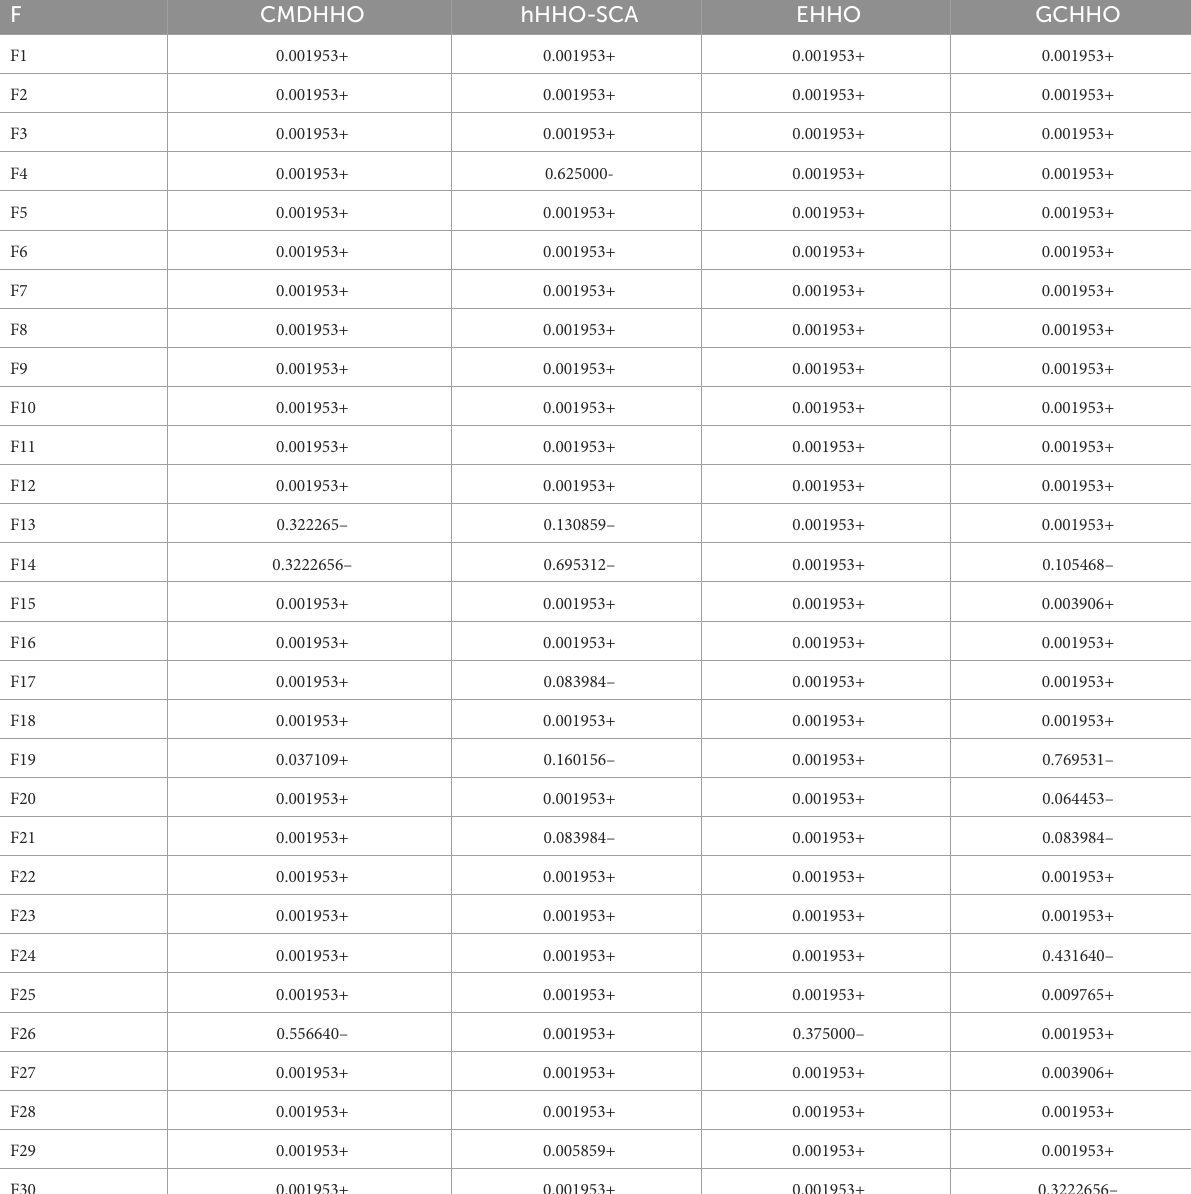
TABLE 4 The calculated p -values for FWHHO vs. existing HHO